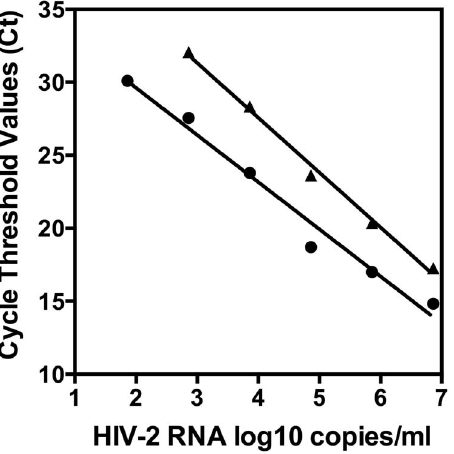
Figure 1. Performance of two HIV-2 primers/probe sets in real- time RT-qPCR assays. Two HIV-2 primers/probe sets were assessed for amplification of serial dilutions of an HIV-2 isolate, NIH-Z, under standard ampification conditions that were not optimized for each primers/probe set. Primers/probe sets, designated as PD = Primer N Design LTD HIV-2 PCR Kit and SM = Delarue et al [12], showed linear . SM = m . amplification profiles that were parallel. PD =